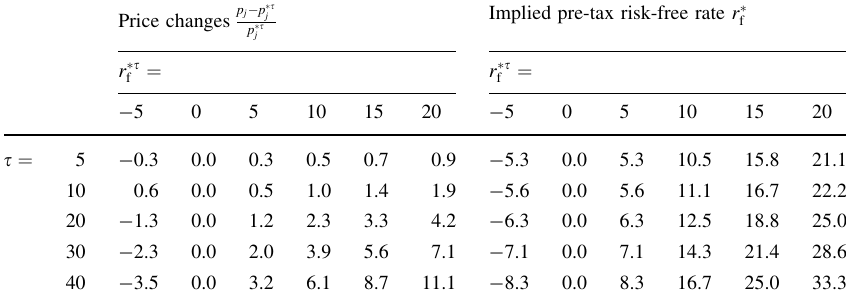
Table 5 Price changes through capital gains taxes for different risk-free